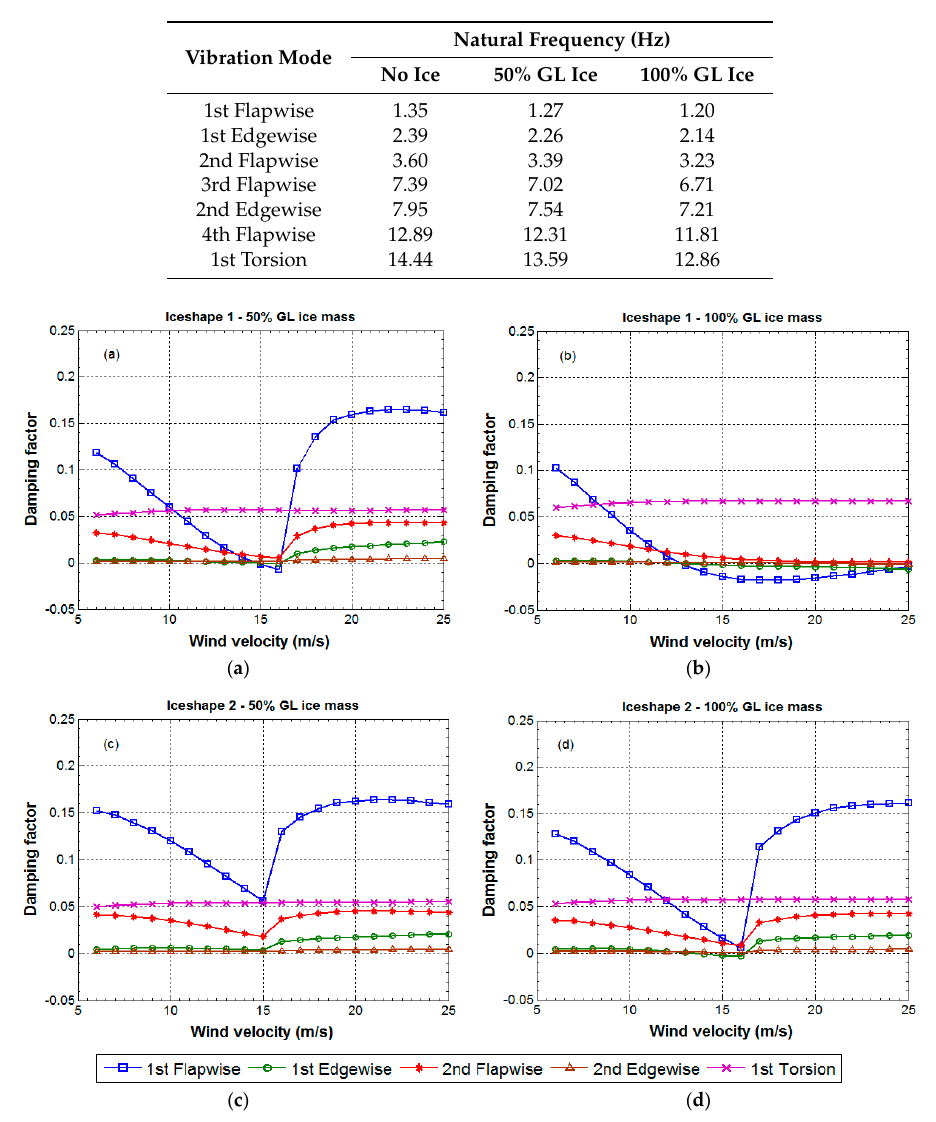
Figure 9. Damping factors of the vibration modes with ( a ) & ( b ) Ice shape 1, 50% and 100% GL ice mass, ( c ) & ( d ) Ice shape 2, 50% and 100% GL ice mass on the blade.